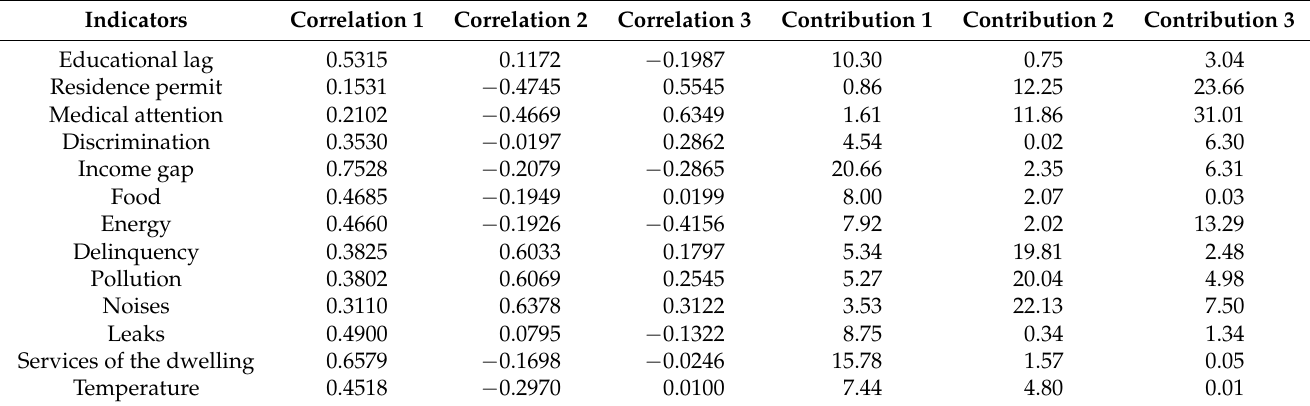
Table 7. Correlations and contributions (%) of candidate principal